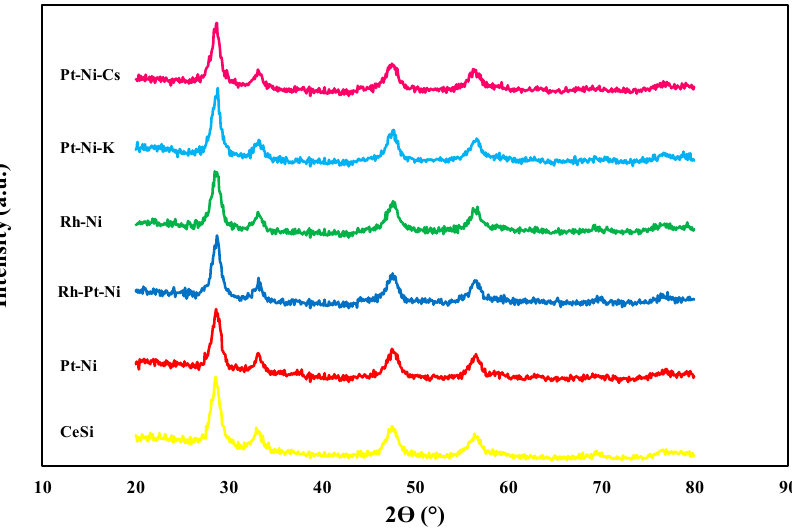
Figure 1. X-ray diffraction patterns of the CeO 2 -SiO 2 support and the catalysts.